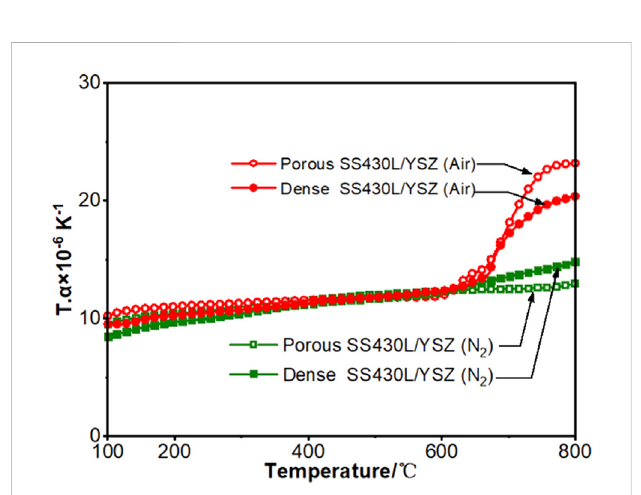
FIGURE 9 Thermal expansion behavior of the SS430L/YSZ porous and dense rods. The dense samples contain 10 wt.% of YSZ only; the porous samples contain 10 wt.% of YSZ plus 24 wt.% of starch. The weight percentages of YSZ and starch are based on